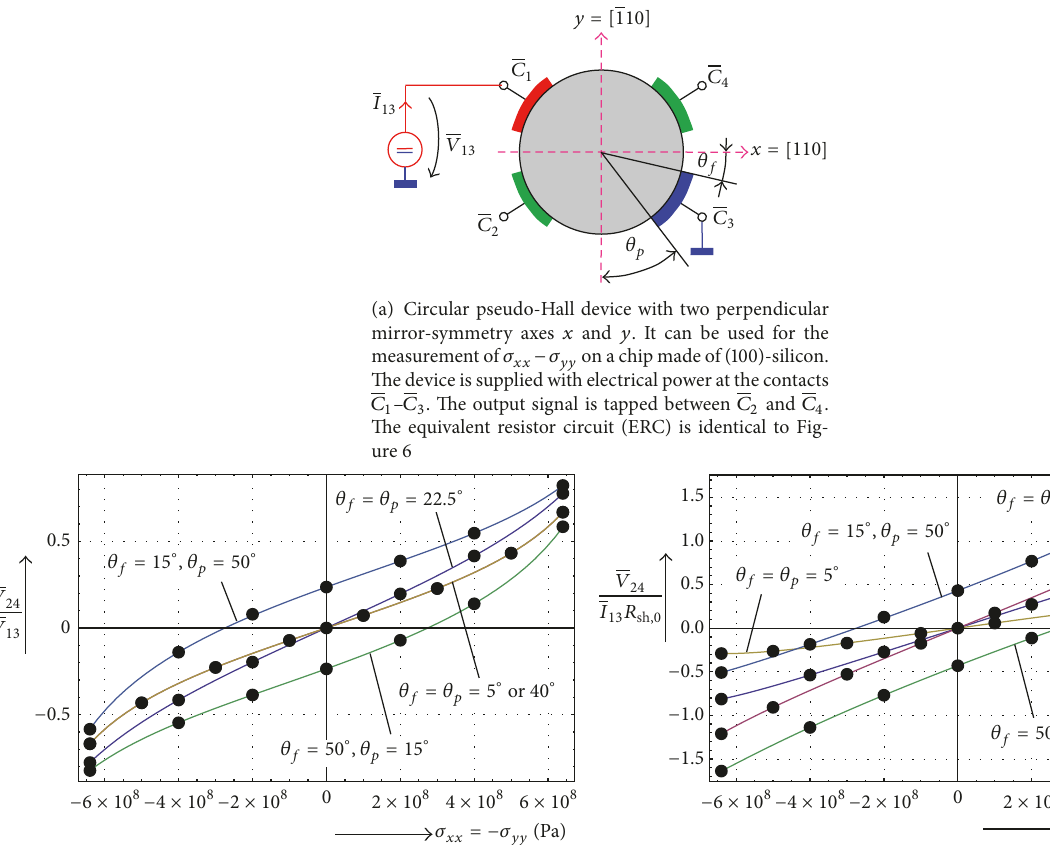
(b) Output voltage of the circular device from (a) versus biaxial inplane mechanical stress 𝜎 𝑥𝑥 = −𝜎 𝑦𝑦 with 𝜎 𝑥𝑦 = 0 . The left plot shows the ratio of output over supply voltage. The right plot shows the ratio of transimpedance over sheet resistance at zero stress 𝑅 sh ,0 . The solid curves are computed with the analytical theory. The black dots denote results form 29 finite element simulations with 𝜋 11 = 6.6 × 10 −11 / Pa , 𝜋 12 = −1.1 × 10 −11 / Pa , and 𝜋 44 = 138.1 × 10 −11 / Pa (as in low p-doped silicon)